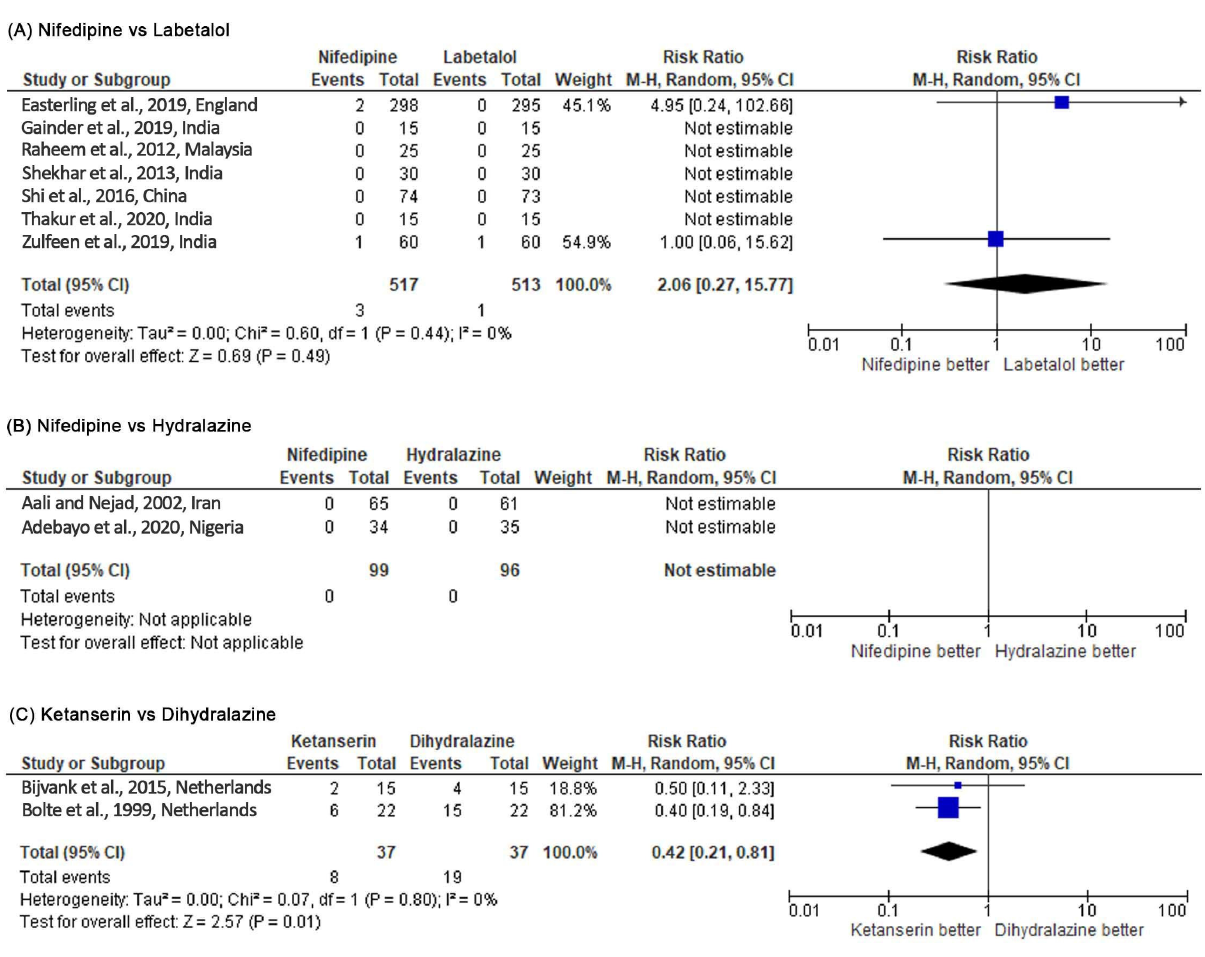
Figure 5. Meta-analysis outcome 2: antihypertensive medication safety comparison assessed by the risk of maternal hypotension incidence. The risk ratio (RR) was used to interpret the risk of maternal hypotension incidence after administering the drug. p -value in the overall effect shows the significance of the RR.